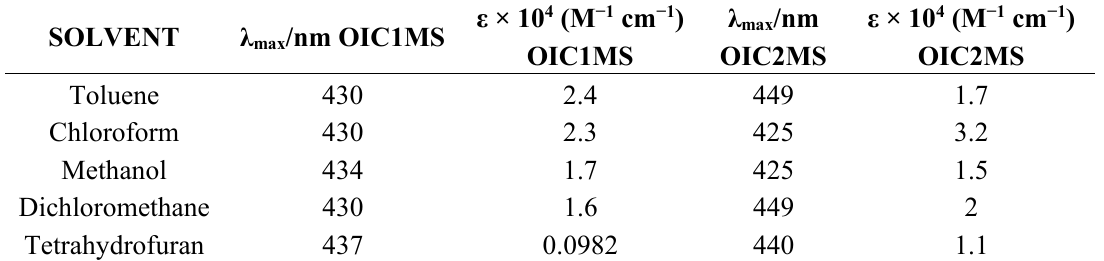
Figure 4. Absorption spectra: ( a ) OIC1MS ; and ( b ) OIC2MS in different solvents at a concentration of 0.004 mg/ mL. Table 1. Optical properties of OIC1MS and OIC2MS in different